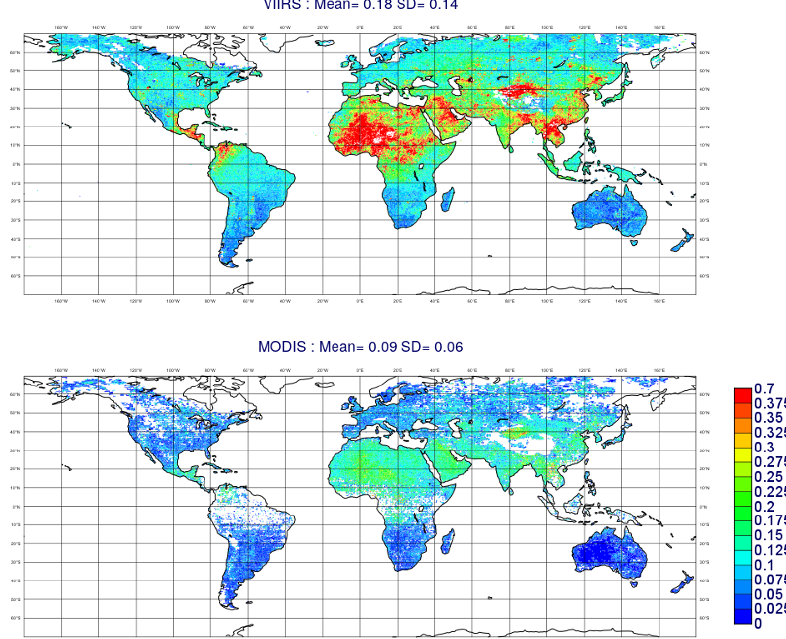
Figure D7. Global maps of the standard deviation of the first-guess departure from Terra and Aqua/MODIS as well as NOAA20 and SNPP/VIIRS for the MAM period over